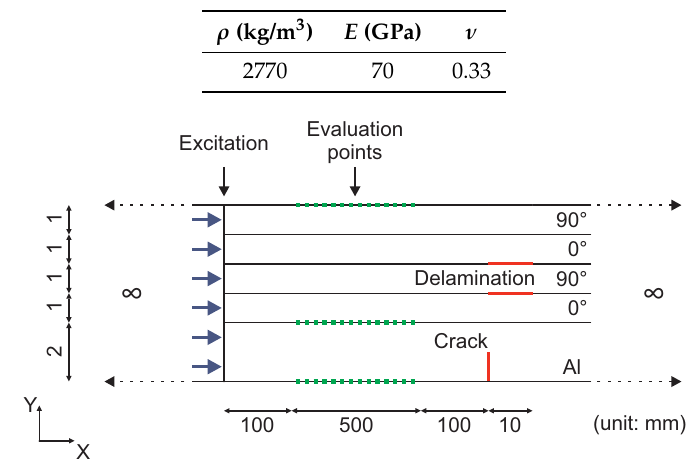
Figure 3. Schematic of the numerical model used in the